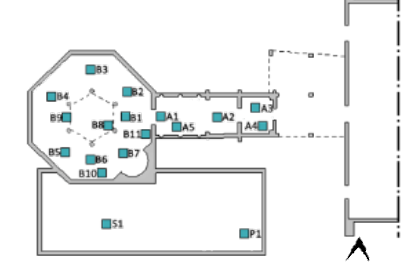
Figure 4. TLS scan positions